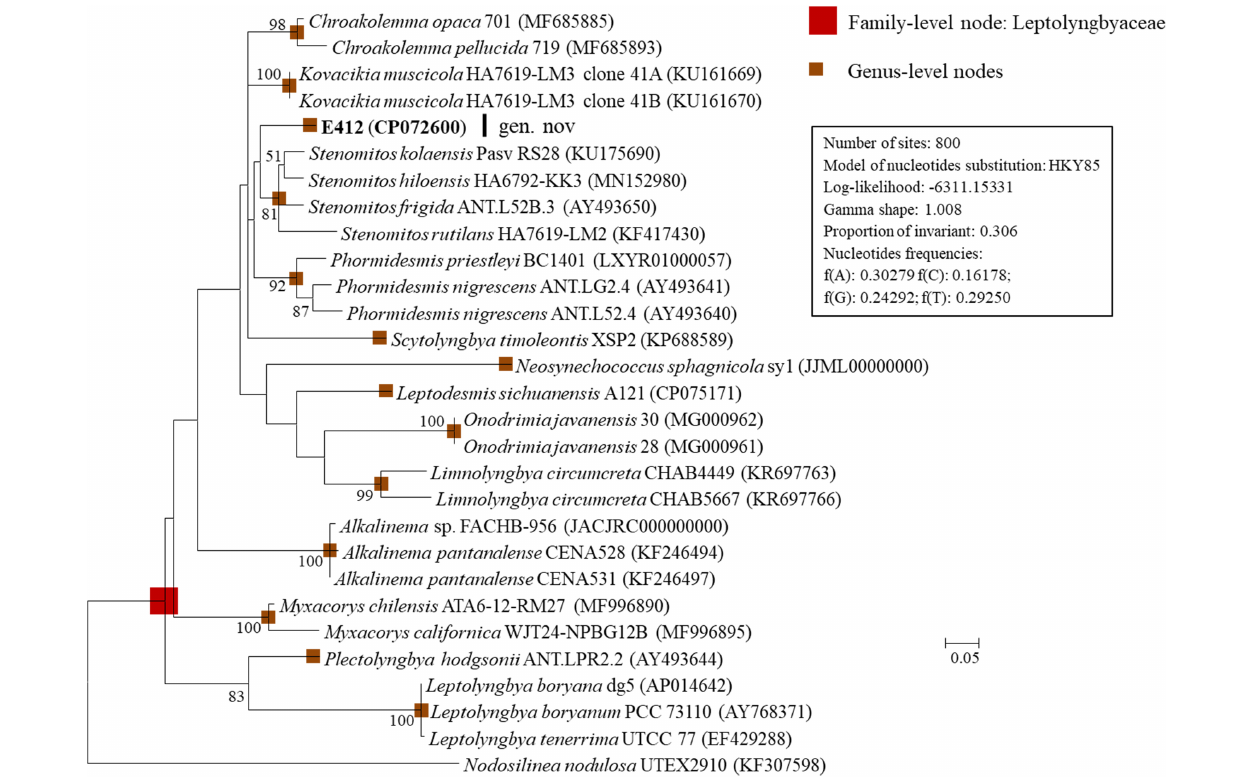
FIGURE 2 | ML phylogenetic tree of 16S-23S ITS sequences. Strain no. in bold represent the strains identified in this study. Only bootstrap values > 50% (1,000 non-parametric replications) are indicated at nodes. Scale bar = 5% substitutions per site. TABLE 1 | The length (bp) summary of regions within16S-23S ITS of Leptolyngbyaceae strains studied. Strain ITS length (tRNA